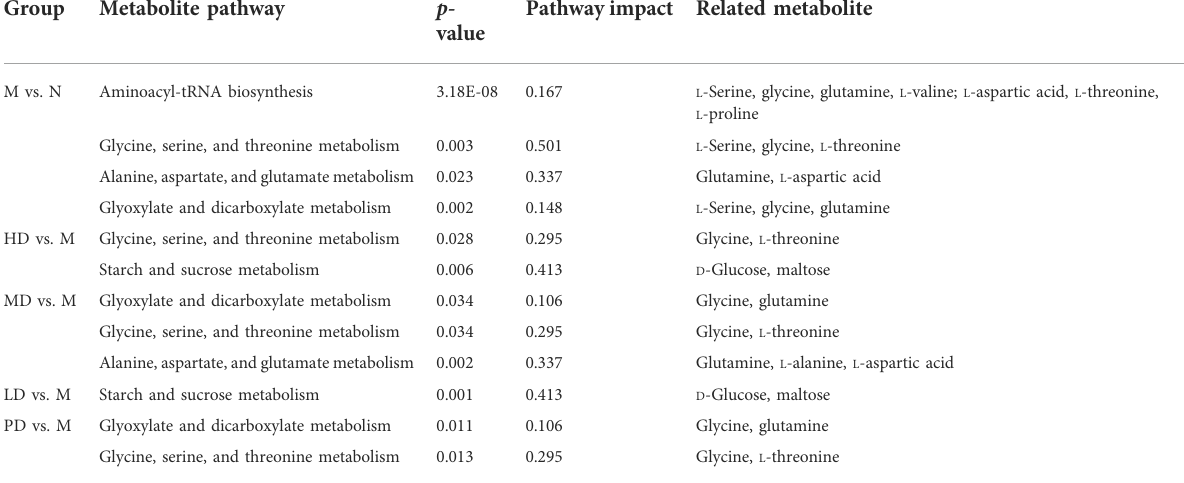
TABLE 3 Intervention of ASH and fl uoxetine on liver metabolic pathways in CUMS mice.